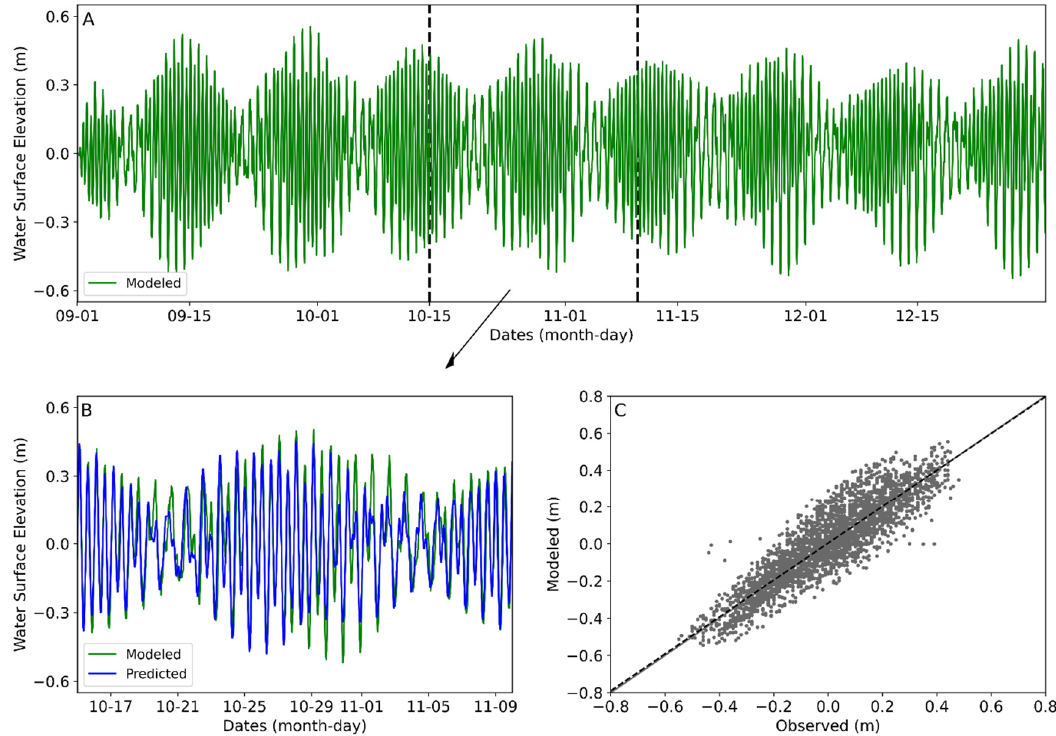
Figure 5. ( A ) Long term water surface elevation modeling for station SC2951, between 1-Sep to 31-Dec; ( B ) Modeled and predicted water surface elevations during a single tidal cycle; ( C ) linear dispersion between predicted water surface elevations between 1-Sep to 31-Dec.